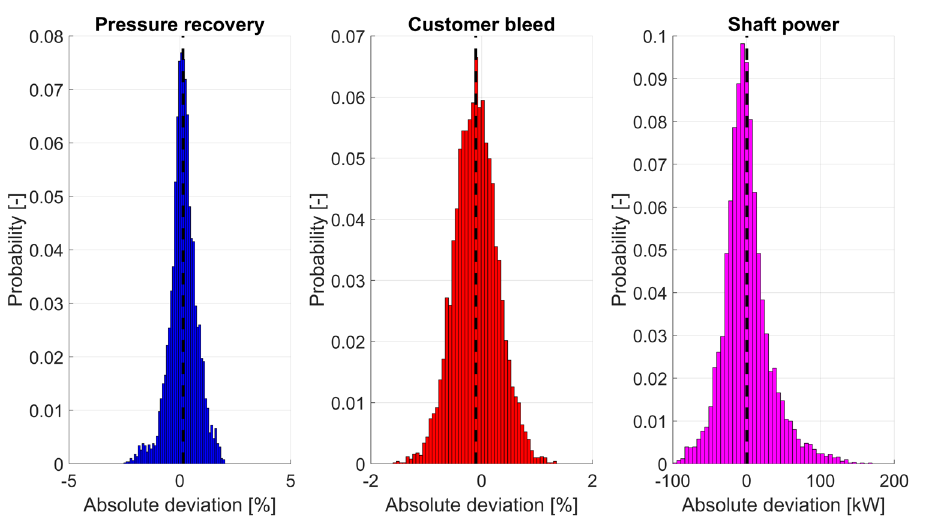
Figure 13. PDF of the error in the estimated installation effects, with measurement noise.